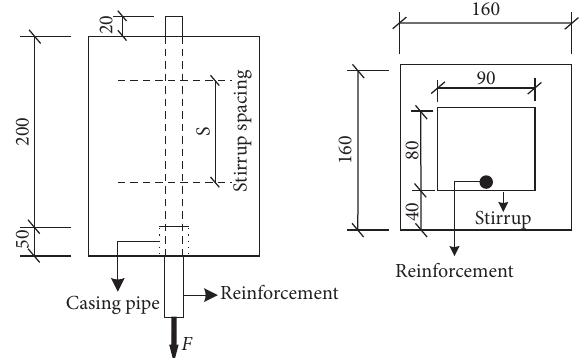
Figure 1: Geometric configuration of the specimen (units: Table 1: Parameters and dimensions of specimens (units: mm).